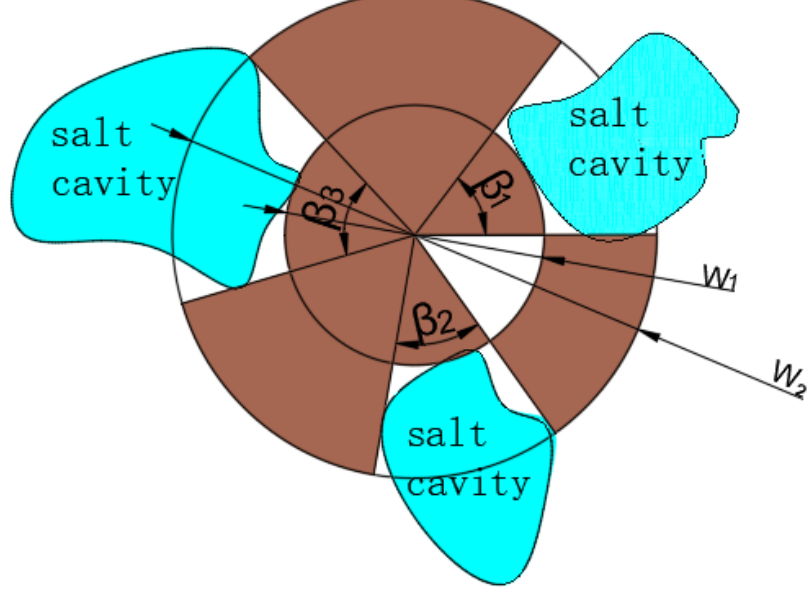
Figure 7. The three-dimensional pillar stress model. In polar coordinates, the radial horizontal stress is influenced by two stresses (e.g., ground stress, and the pressure in the cavern). The tangential stress is affected by the aspect ratio of the pillar. Additionally, the following group’s equation was adopted [25].